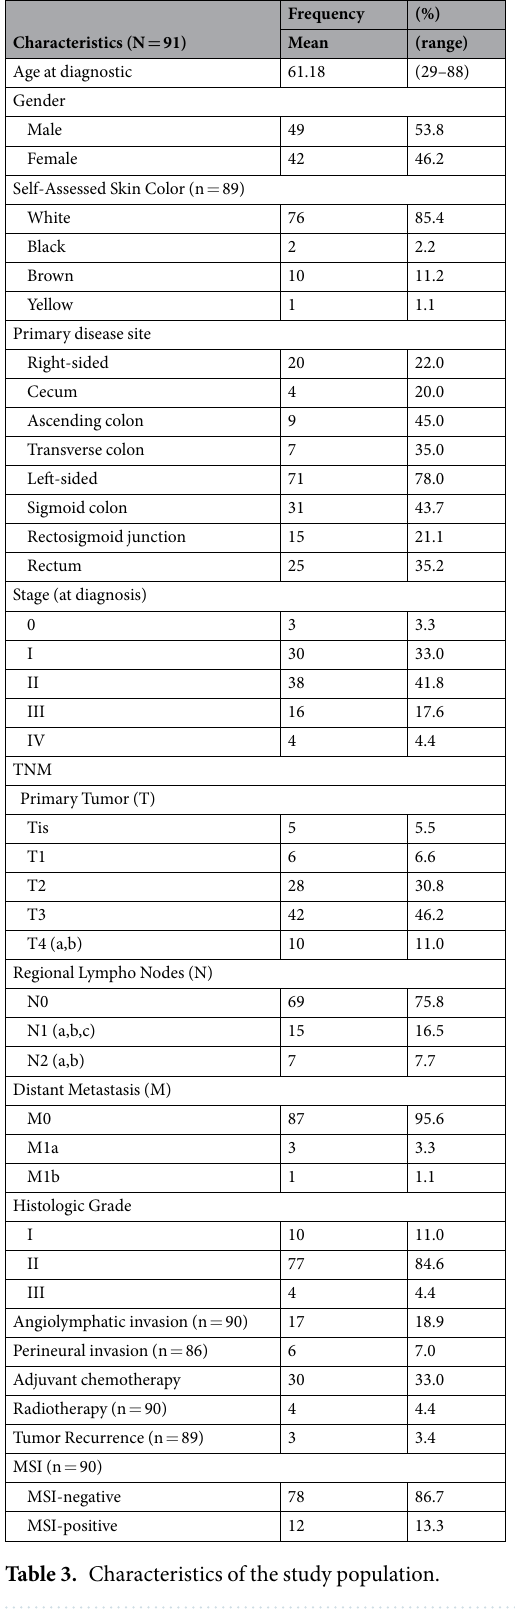
Table 3. Characteristics of the study